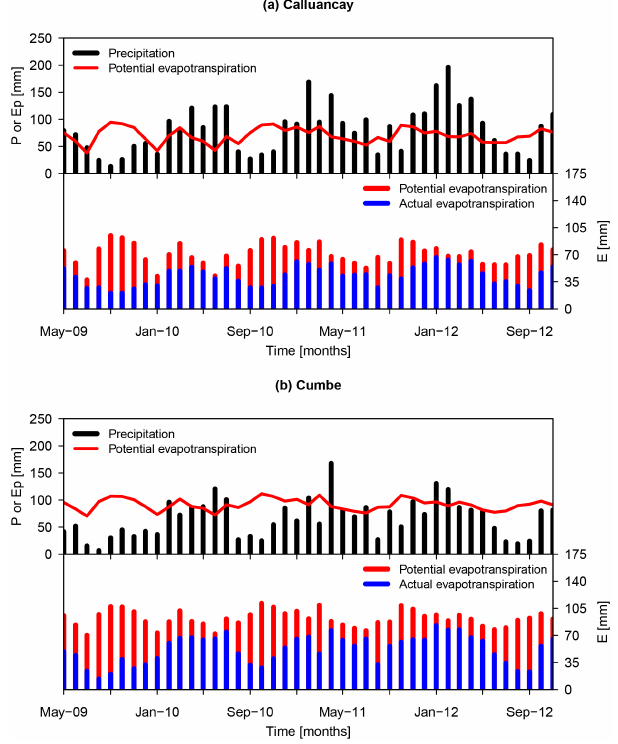
Figure 7. Time series of precipitation ( P) , potential evapotranspi- ration ( E p ), and actual evapotranspiration ( E a ) in order to identify vegetation stress and recovery